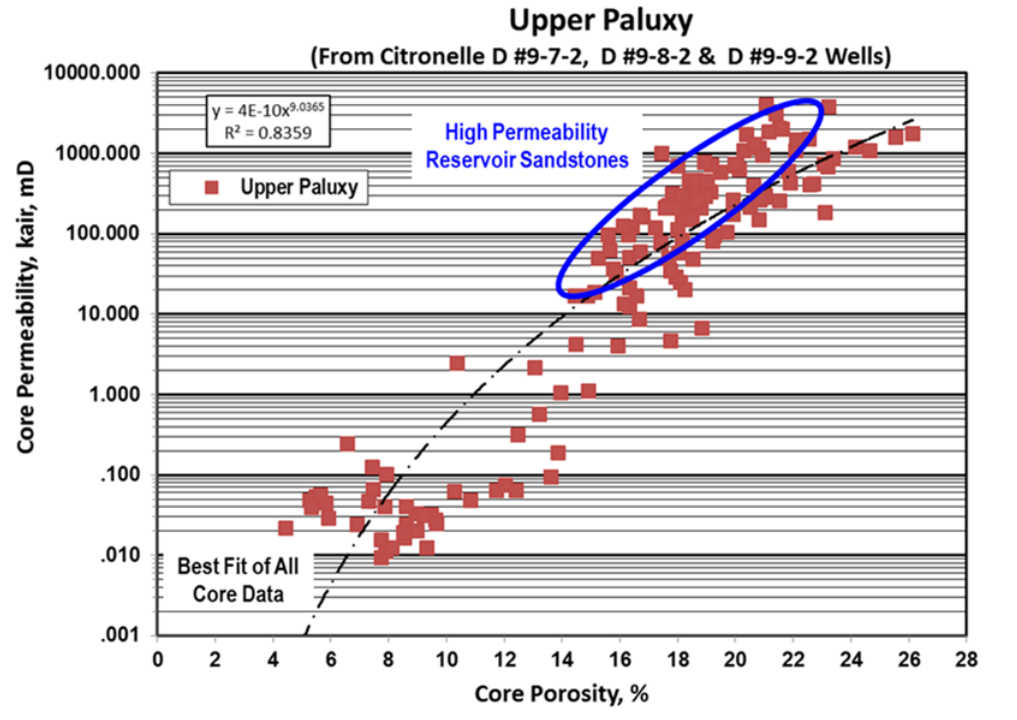
Figure 10. Cross-plot of core derived porosity and permeability for the upper Paluxy Formation from each stratigraphic test well. Source: Author conception.